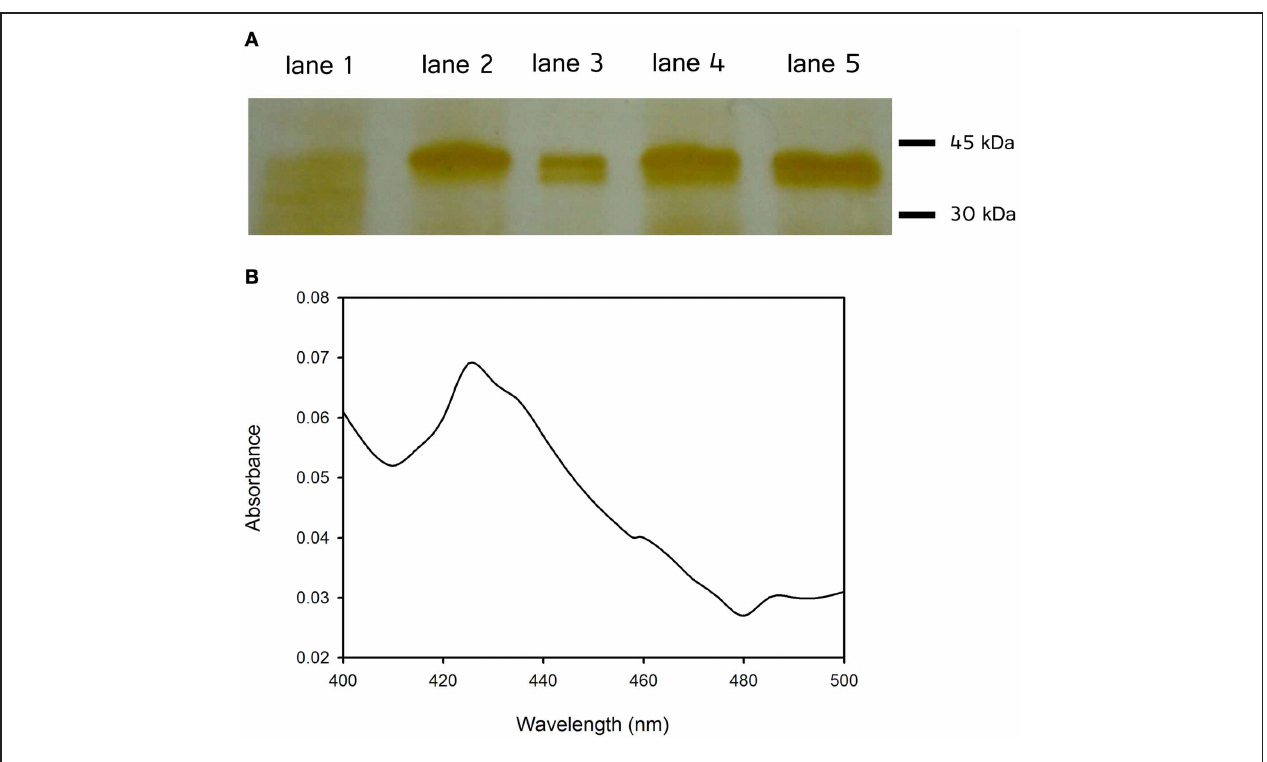
FIGURE 7 | (A) SDS–PAGE of partial purified proteins using immobilized metal ion chromatography (Ni 2 + IMAC): vector without insert (lane 1), CYP52X1 (lane 2), CYP5337A1 (lane 3), CYP617N1 (lane 4), and CYP53A26 (lane 5). Examined proteins were expressed in the yeast Saccharomyces cerevisiae WAT11. The cells were transformed with the lithium acetate